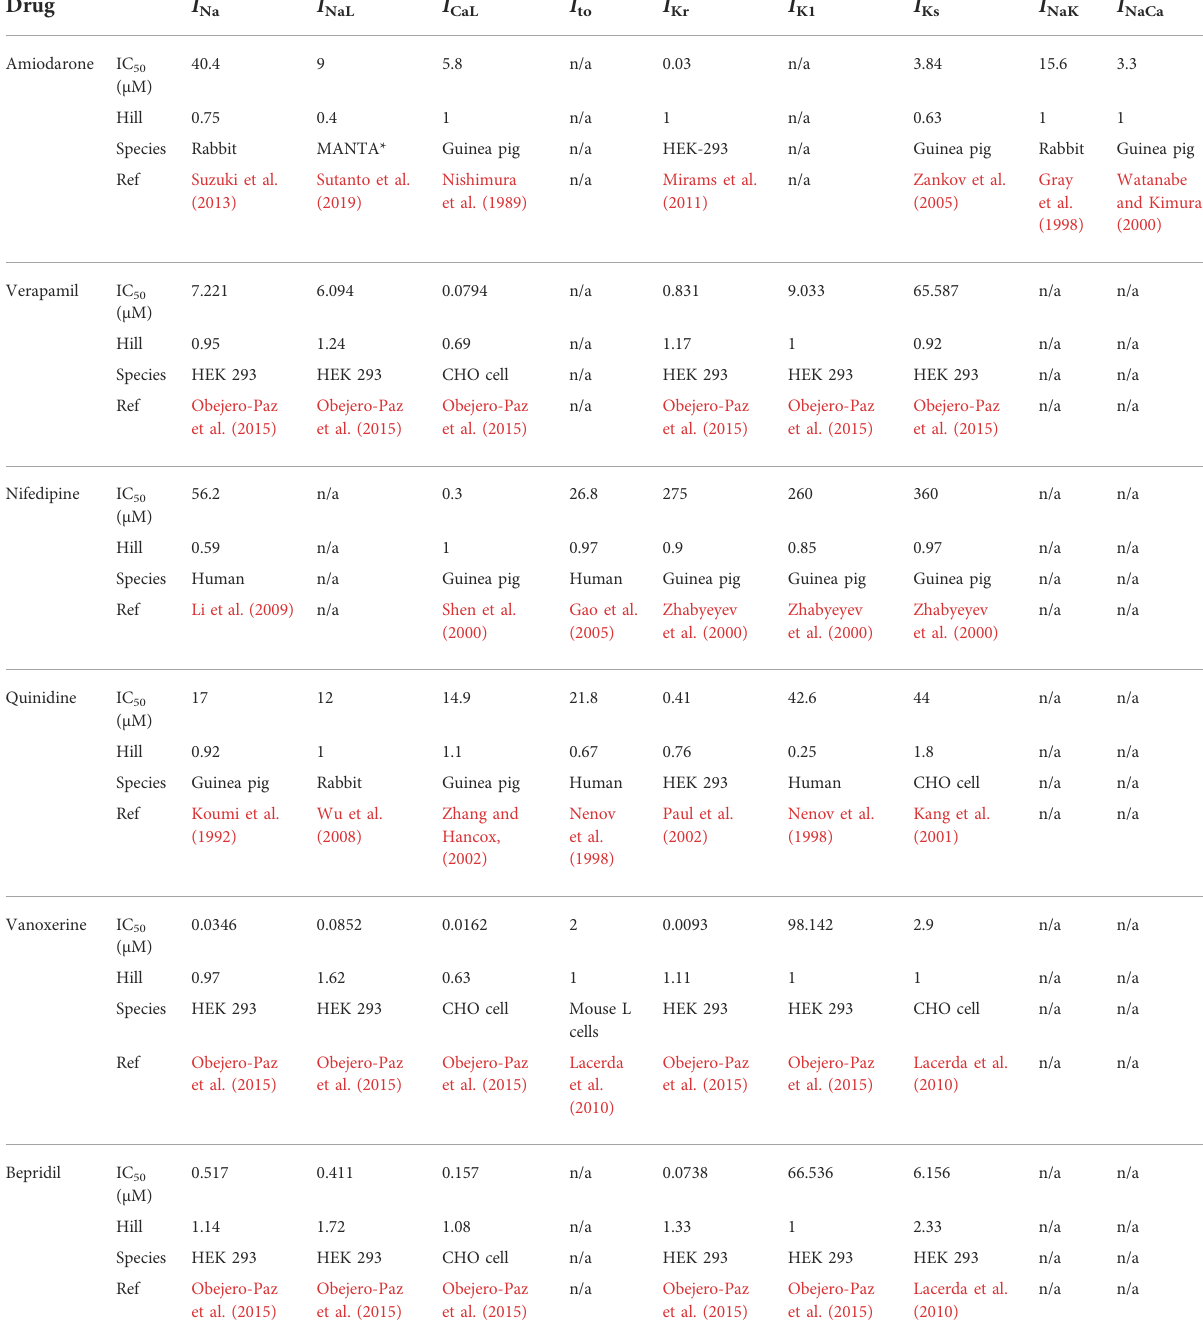
TABLE 2 Summary of data for six multi-channel